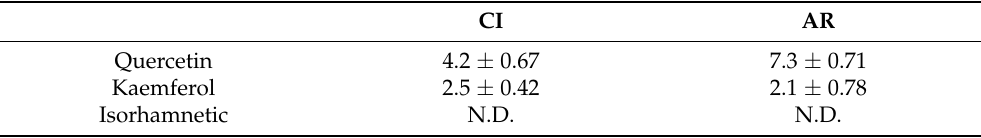
Table 4. Contents of flavonoids in CI and